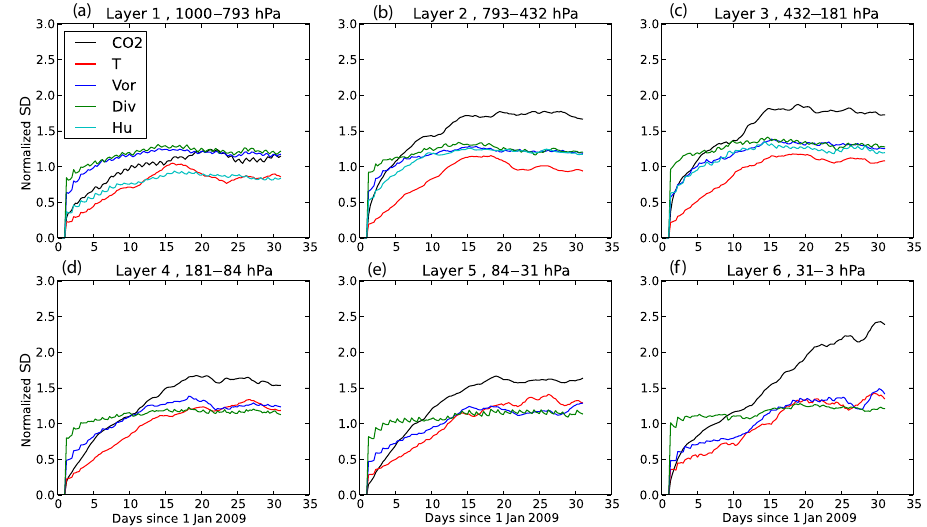
Figure 10. Time series of layer mean normalized predictability error during January 2009 for CO 2 (black curves), temperature (red curves), vorticity (blue curves), divergence (green curves) and specific humidity (cyan curves). For clarity, no curves for specific humidity are plotted in the bottom row of panels. The normalized errors are averaged over 12 model levels; the top and bottom levels used in the average are given in approximate pressure above each panel. The layer numbers are associated with the layers defined by dashed horizontal lines in Fig. 9 and correspond to the near surface (layer 1, a ), the lower troposphere (layer 2, b ), the mid-troposphere (layer 3, c ), the upper troposphere (layer 4, d ), the lower stratosphere (layer 5, e ) and the upper stratosphere (layer 6, f